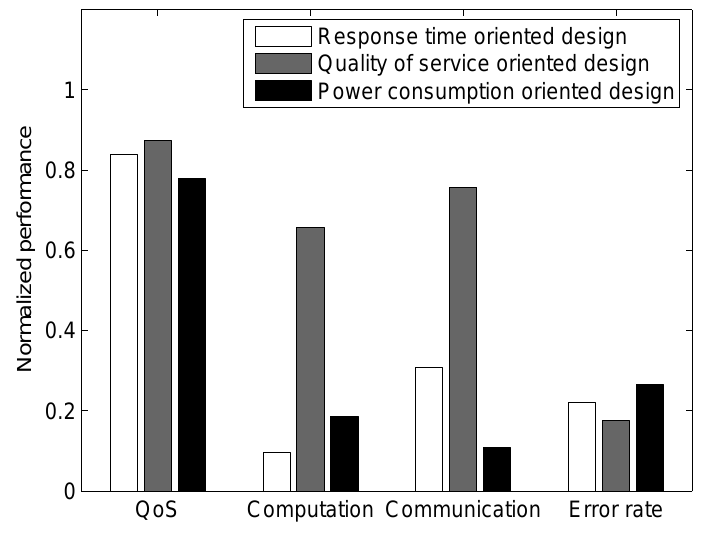
Figure 26. Performance of multi-agent systems under three different